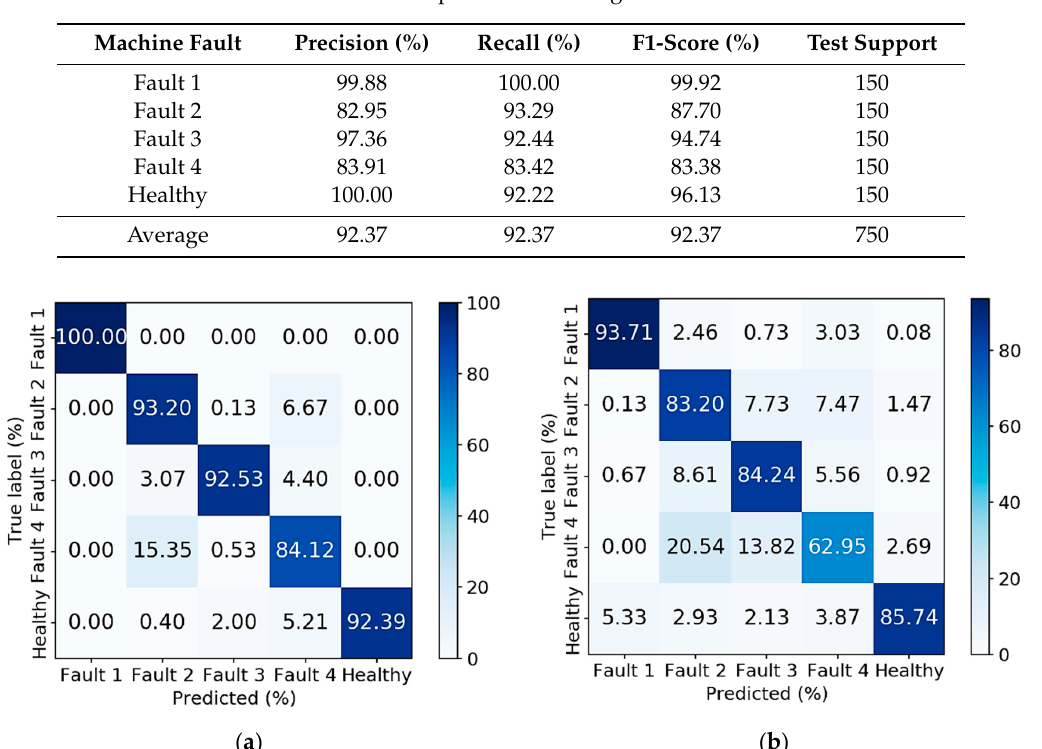
Table 3. Classification report when loading conditions are used.